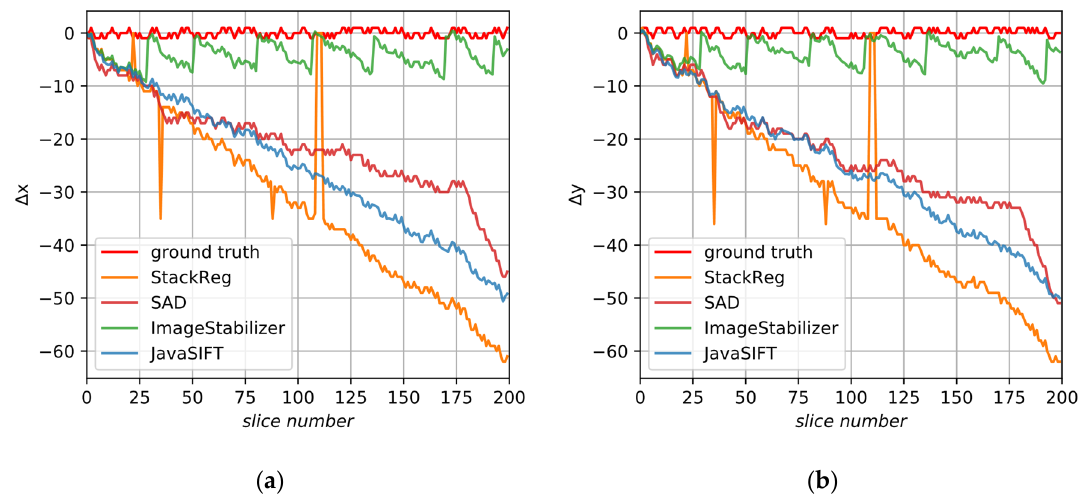
Figure 12. The displacements calculated by existing alignment algorithms for the synthetic sample: ( a ) in the X axis; ( b ) in the Y axis.